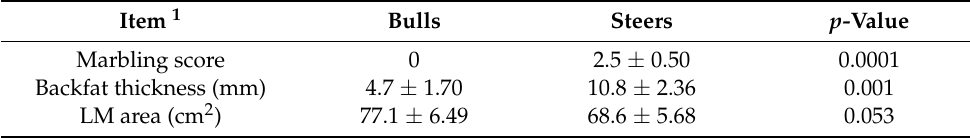
Table 3. Effect of early castration on chemical and physio-chemical compositions of the Holstein cattle.